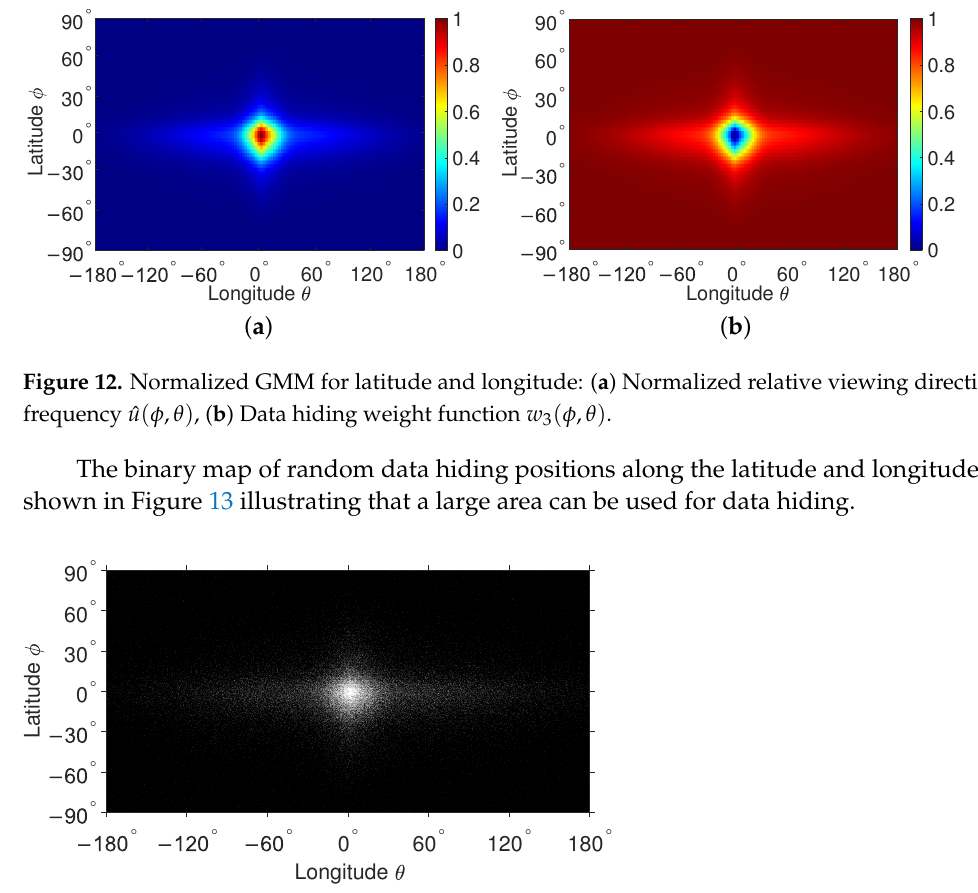
Figure 13. Binary map of random data hiding positions along the latitude and longitude (Black: Pixel used for data hiding; White: Pixel not used for data